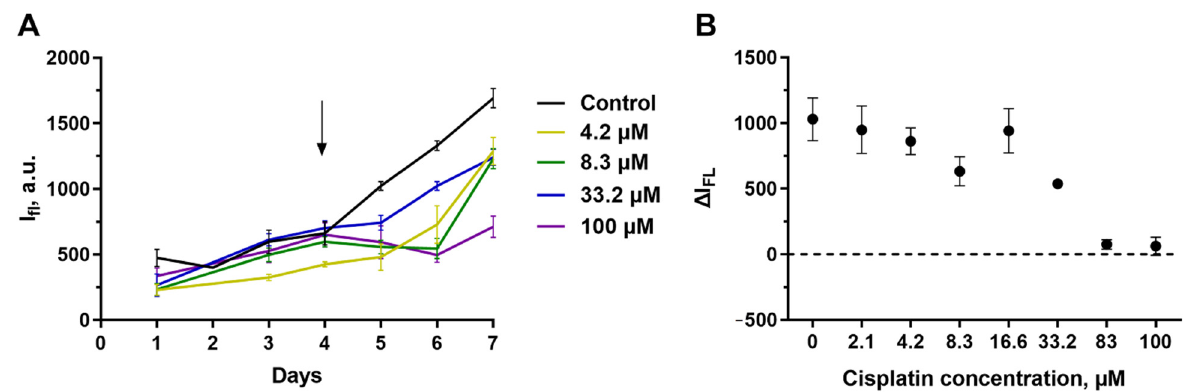
Figure 5. Cytotoxicity of cisplatin against A431-GFP cells embedded in collagen hydrogel. ( A ) Dynamics of changes in the fluorescence signal from hydrogels treated with different concentrations of antitumor agents. On day ‘zero’, 2 × 10 5 cells were embedded in the gel. The day cisplatin was added to the medium is indicated by an arrow. ( B ) Δ I FL values 72 h after the start of hydrogel’s exposure to cisplatin. The data are presented as mean ± standard deviation.